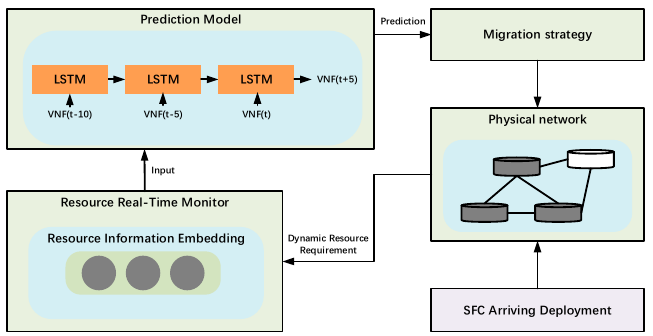
Figure 2. Overall RP-EDM architecture.